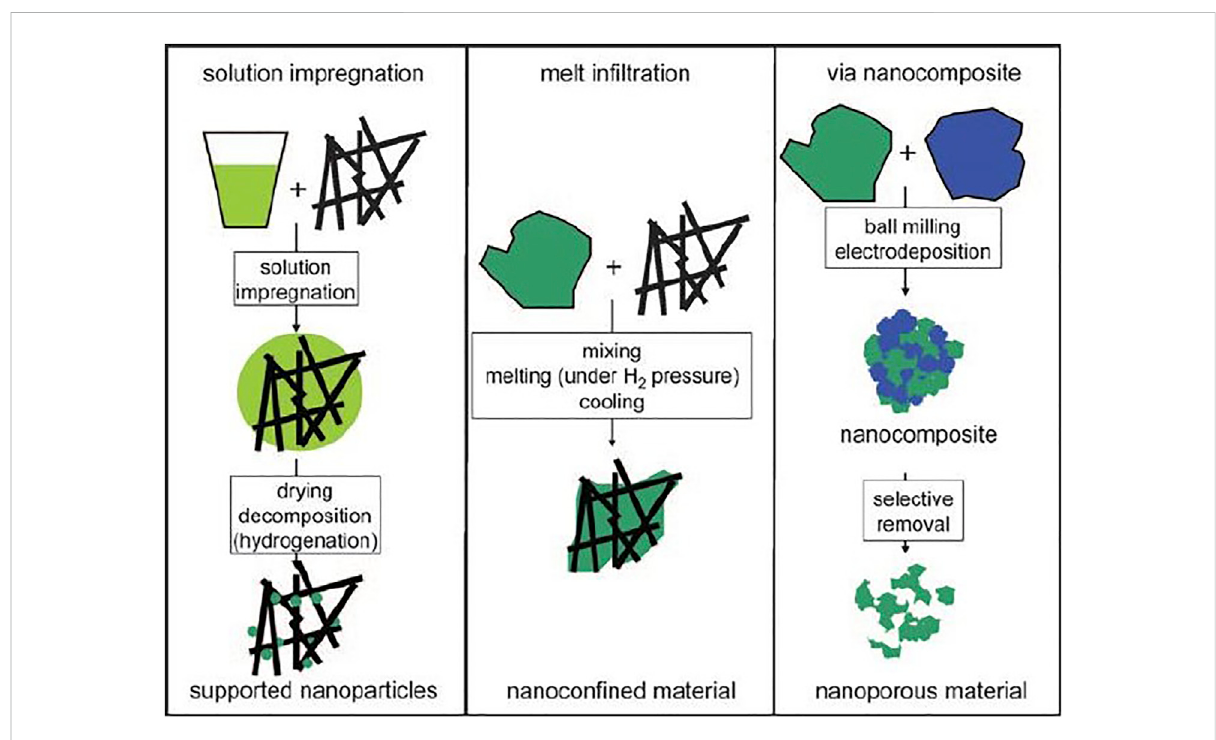
FIGURE 3 Schematic illustration of different ways to prepare nanostructured metal coordination hydrides or metal hydrides (Jongh and Adelhelm, 2010).